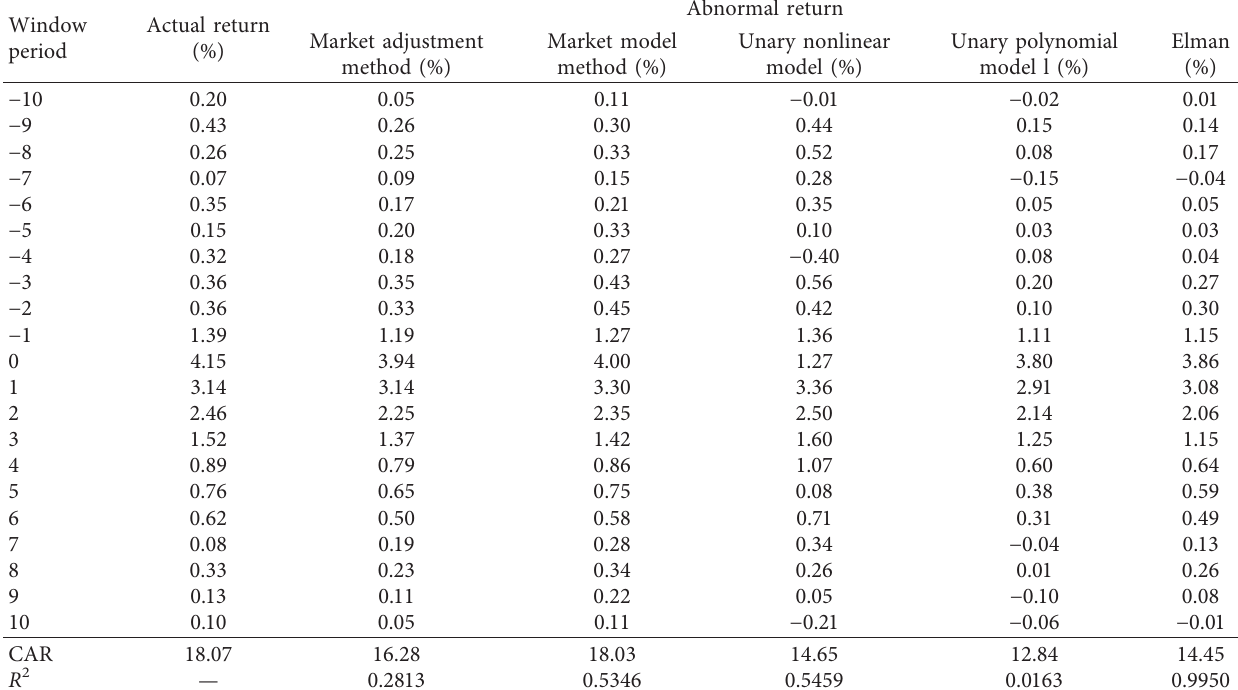
Table 3: The AR in window period and fitting result of the five models.